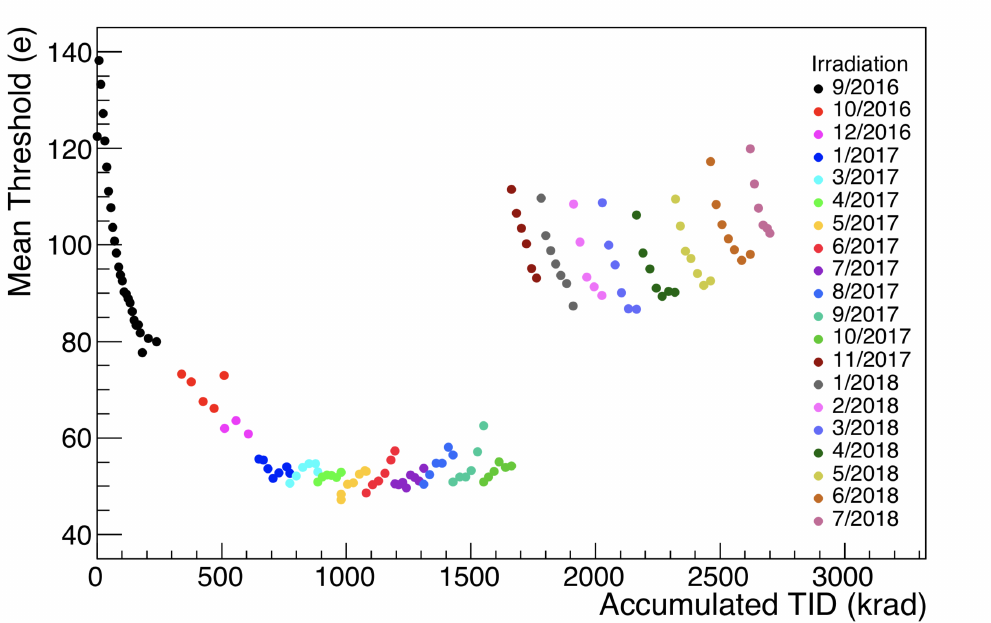
Figure 8. Mean threshold versus accumulated total ionizing dose. The dates of the performed campaigns are quoted in the legend.